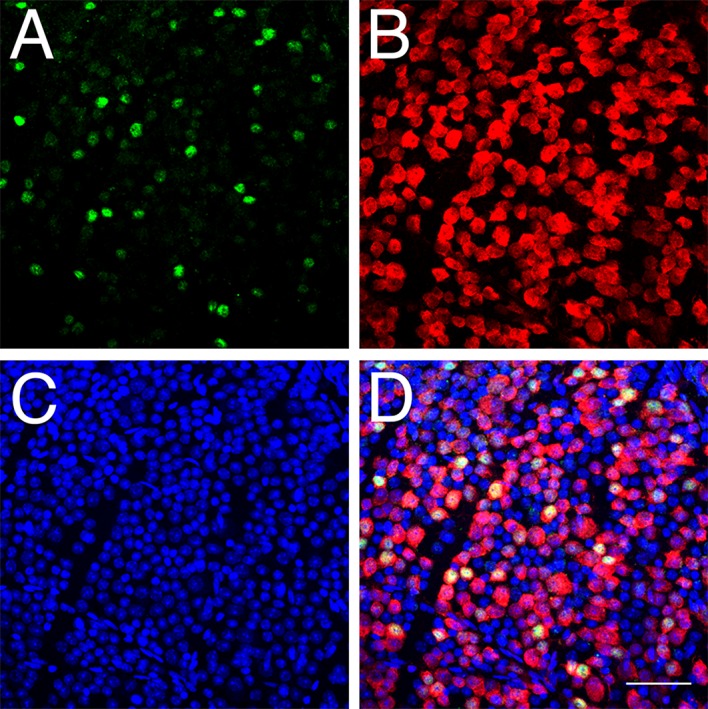
The labeling of RGCs with an antibody directed against POU6F2 is illustrated in a flat-mount of the mouse retina.Panel A is the staining within the retina (green) for POU6F2. The same area (panel B) was stained (red) for the ganglion cell marker Class III beta tubulin. Nuclei in the ganglion cell layer were stained blue with TOPRO-3 (panel C). The merged image is shown in D. Notice that many of the ganglion cells were heavily stained for POU6F2 and that others are lightly labeled. The scale bar in D represents 50μm.